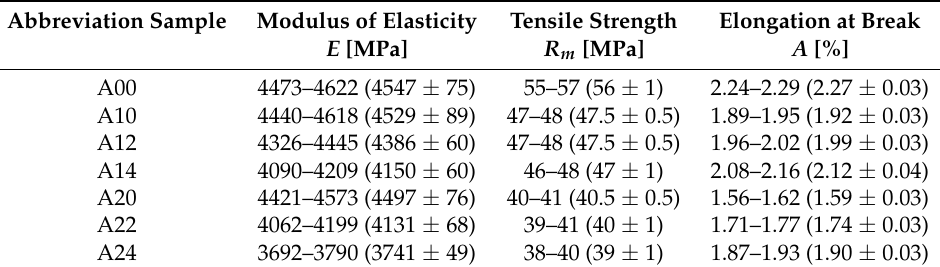
Table 2. Type “A” hemp fabric reinforced samples: lower and upper values (arithmetical average value and deviation value) for the elasticity modulus, tensile strength, and elongation at